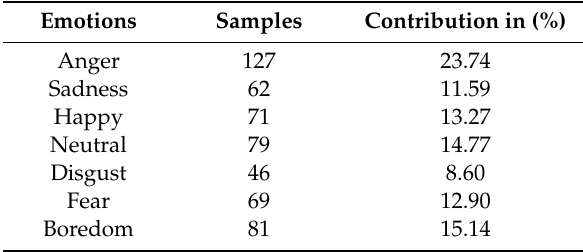
Table 3. The detailed description about the berlin emotional speech database EMO-DB dataset in term of the emotions, the numbers of utterances, and participation rates in